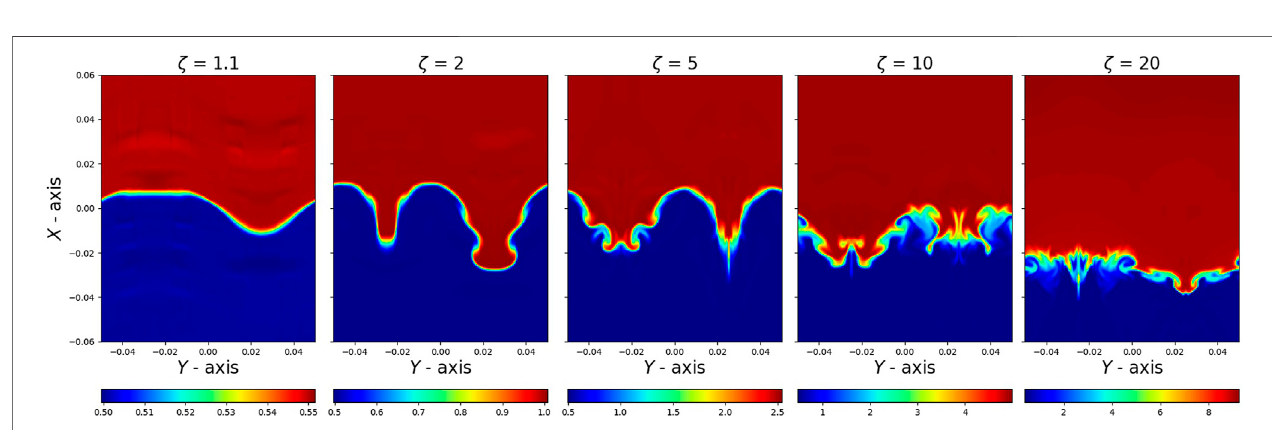
FIGURE 2 | Snapshots of evolution of density at half of the z domain according to the table and t (cid:1) 4. Plots vary for different density contrast ζ (cid:1) {1.1, 2, 5, 10, 20}, where V (cid:1)